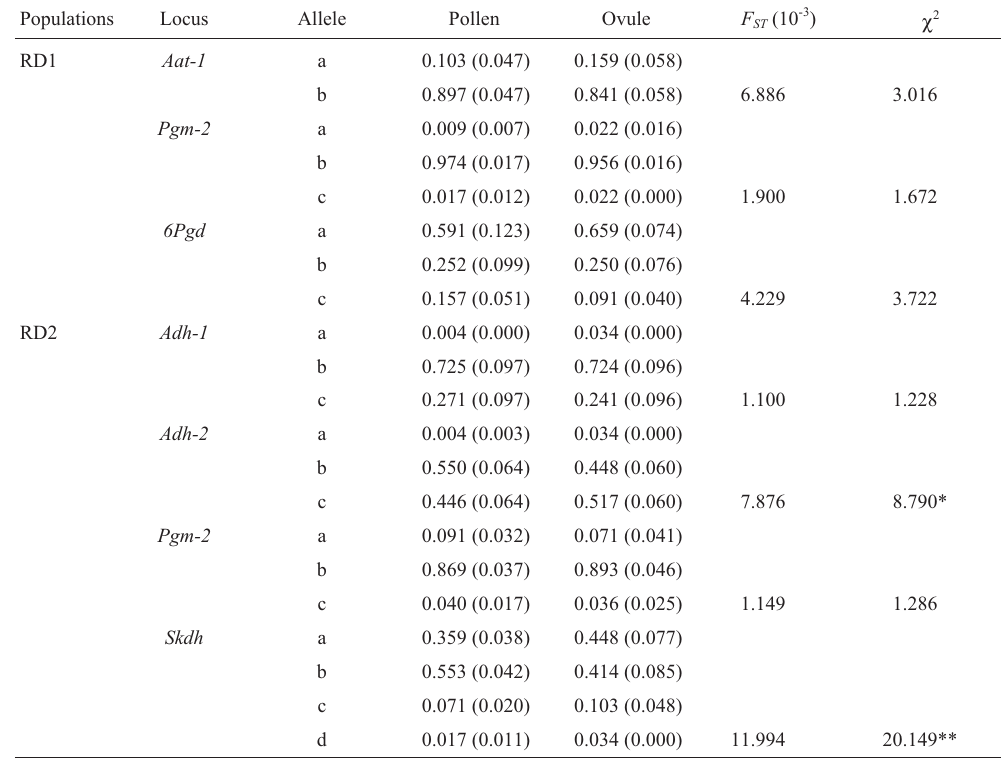
Table 2 - Pollen and ovule allele frequencies for populations of Senna multijuga and χ 2 -test results for the differences between these frequencies. F ST is the genetic difference between populations. Standard errors are shown in parentheses. Populations